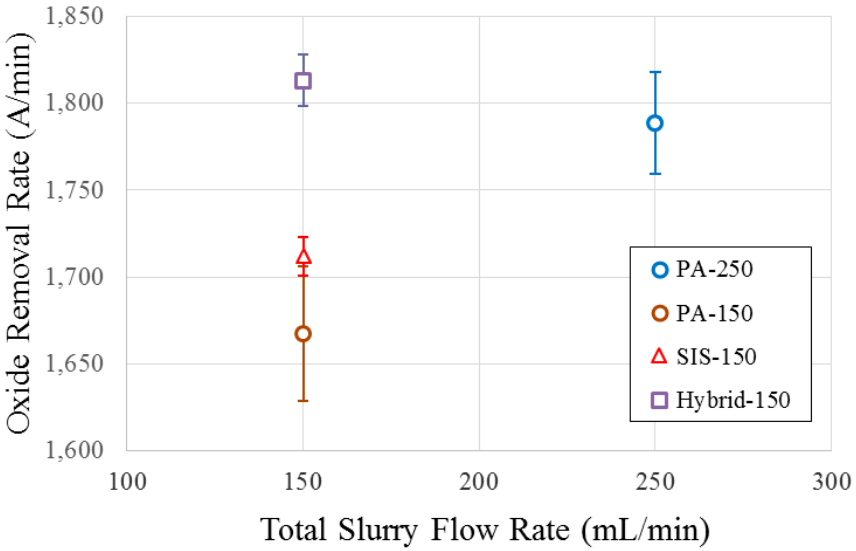
Figure 3. Summary of removal rate data. PA-250: polishing using the PA method at a slurry flow rate of 250 mL/min; PA-150: polishing using the PA method at a slurry flow rate of 150 mL/min; SIS: polishing using the SIS method at a slurry flow rate of 150 mL/min; Hybrid-150: polishing using the hybrid method (SIS at a slurry flow rate of 50 mL/min + PA at a slurry flow rate of 100 mL/min) at a total slurry flow rate of 150 mL/min.